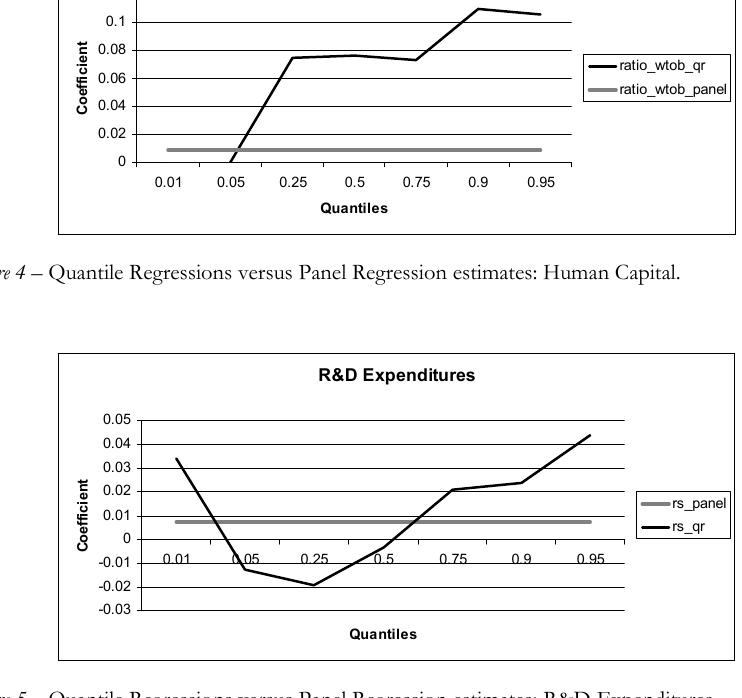
Figure 5 – Quantile Regressions versus Panel Regression estimates: R&D